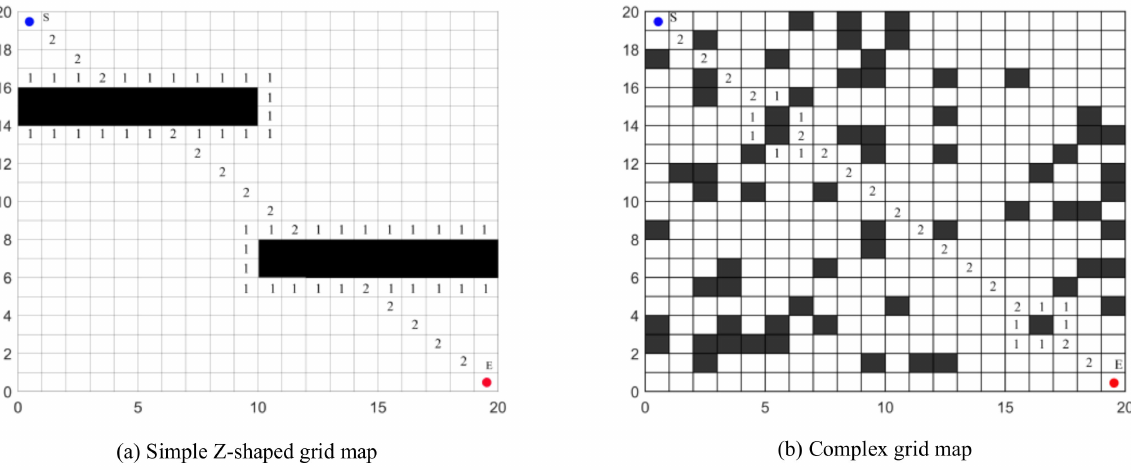
Figure 6. A large value will lead to densely distributed initial